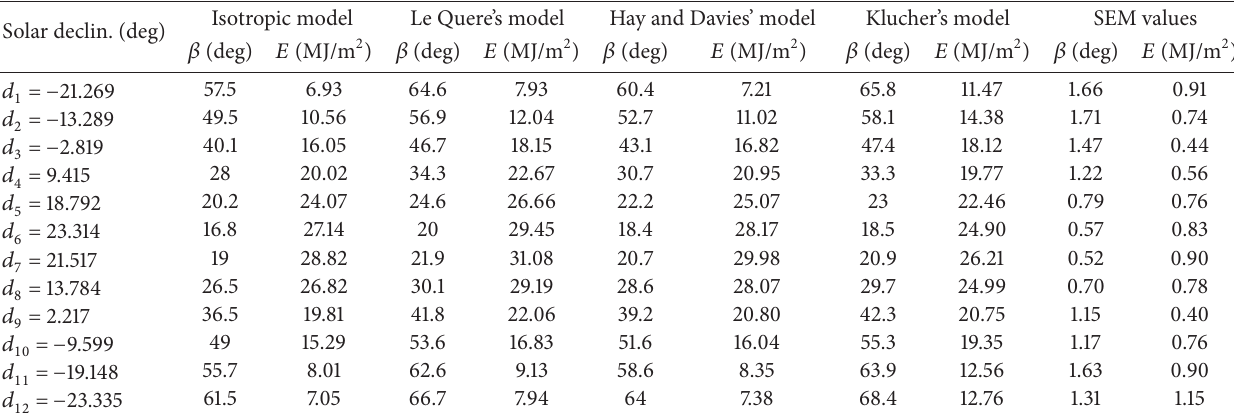
Table 3: Optimum tilt angle values and monthly mean of thedaily global solar radiation values computed by means of the algorithm proposed in Section 2 applied to the monthly averages of the daily global horizontal solar irradiation data acquired from 1985 to 1989 at the site of Rome (latitude +41 ∘ 54 󸀠 N; longitude +12 ∘ 27 󸀠